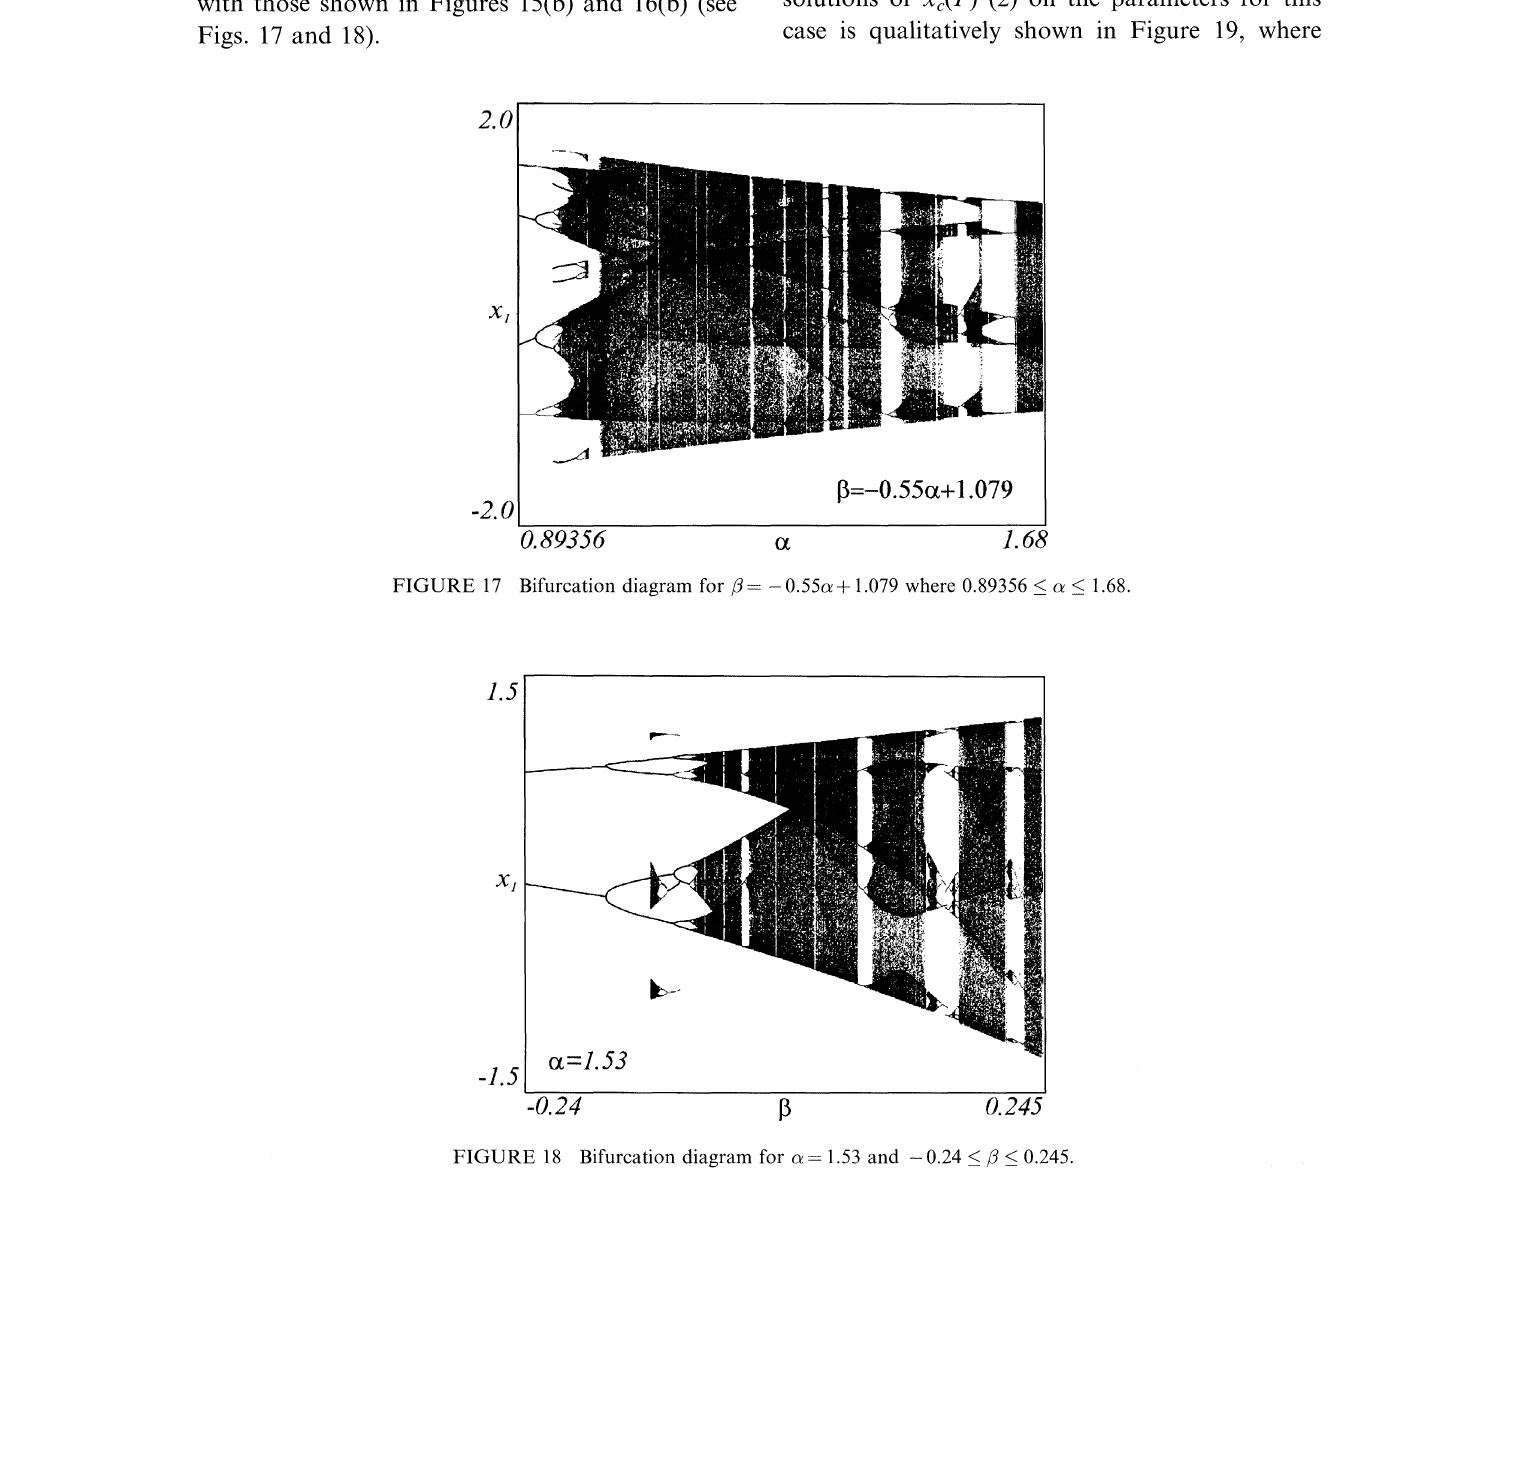
FIGURE 18 Bifurcation diagram for c= 1.53 and -0.24 _</3 <